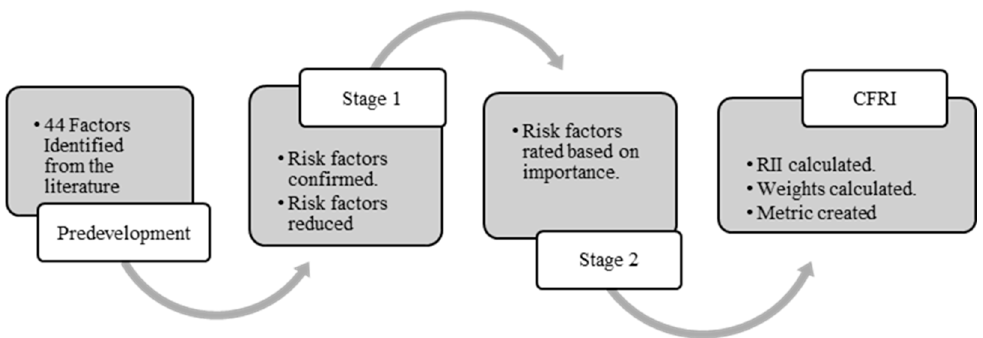
Figure 1. CFRI development stages.